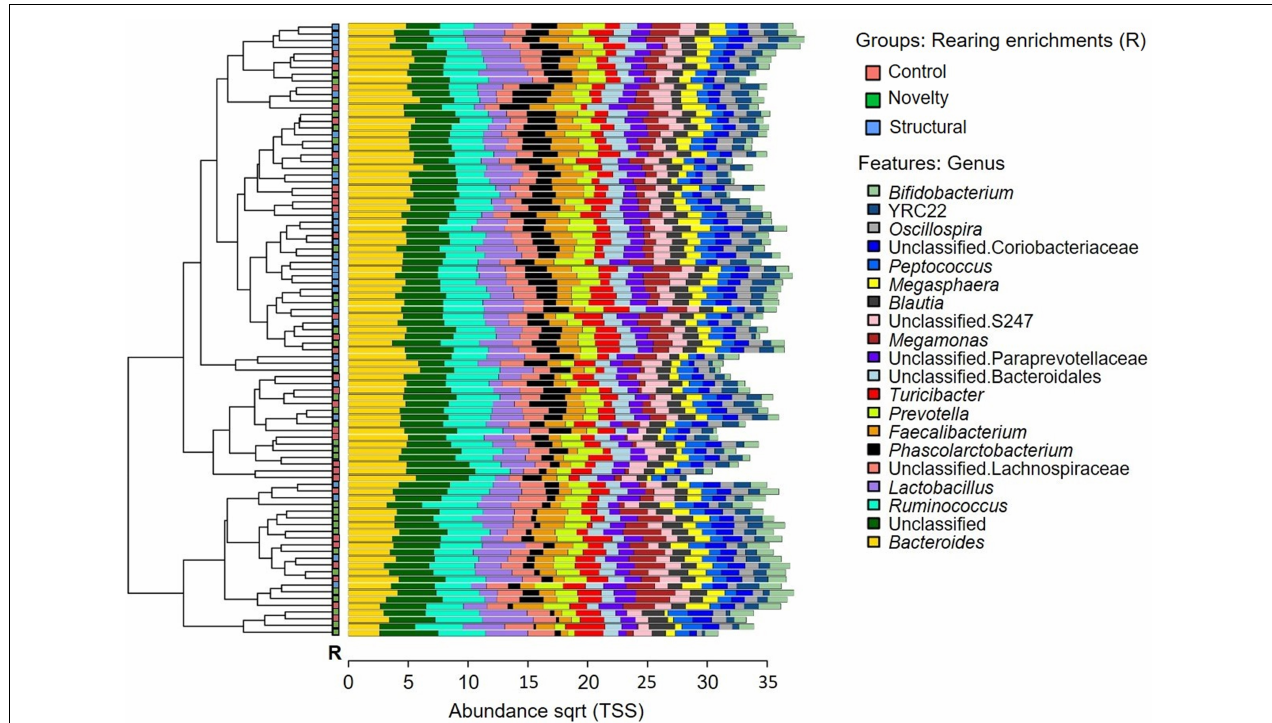
FIGURE 4 | Microbial community composition of free-range hens at 65 weeks of age from different rearing enrichments (control, novelty, structural). Clustered bar chart showing 20 most abundant genera.